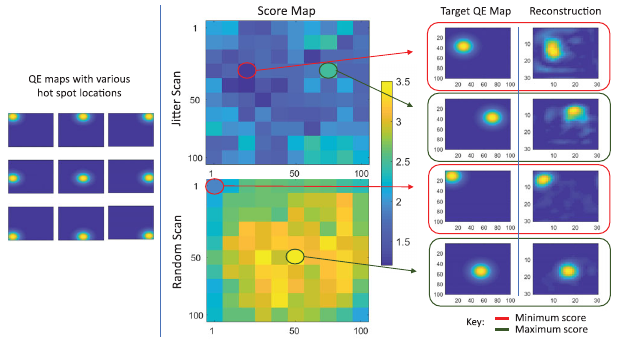
FIG. 3. Simulation results using UCLA jitter (top) and random scan (bottom) datasets for a collection of QE maps each containing one 2D Gaussian-shaped hot spot with a centroid placed at a unique location. The left-most image shows a subset of the generated QE maps. The score maps (middle) represent the performance of a reconstruction with a target hot spot centered at the coordinate within the map. The score is defined in Eq. (2). The right-most figures show the best and worst scored recon- structions side-by-side with the target QE map. Note that the reconstructions have the same size of as the VCC images, and are upsized to match the dimensions of the target QE map during score calculations. Some of the jitter reconstructions include artifacts, but both methods identify the QE